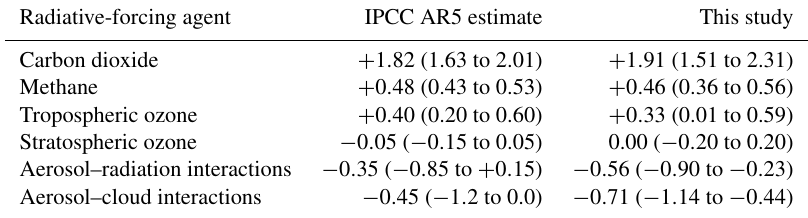
Table 8. Comparison of best estimate and 5%–95% confidence ranges for stratospherically adjusted radiative forcing (in Wm − 2 ) as assessed by the Fifth Assessment Report (AR5) of the Intergovernmental Panel on Climate Change (IPCC; Sect. 8.3.2 and Table 8.6 of Myhre et al., 2013a) and obtained by this study, both for 2011 relative to 1750. AR5 estimates for aerosol–cloud interactions are for the effective radiative